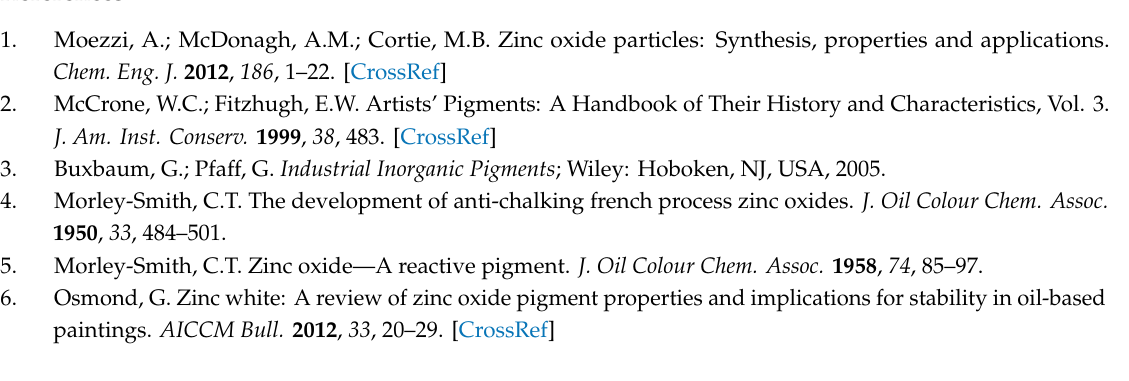
Figure S1: X-Ray Powder Di ff raction, Figure S2: Thermogravimetric analyses, Figure S3: Near-band-edge Photoluminescence, Figure S4: Near-band-edge at variable fluence, Figure S5: RhB Absorption spectra, Table S1: Lifetime Near-band-edge, Table S2: Lifetime Trap-assisted, Scheme S1: Rhodamine